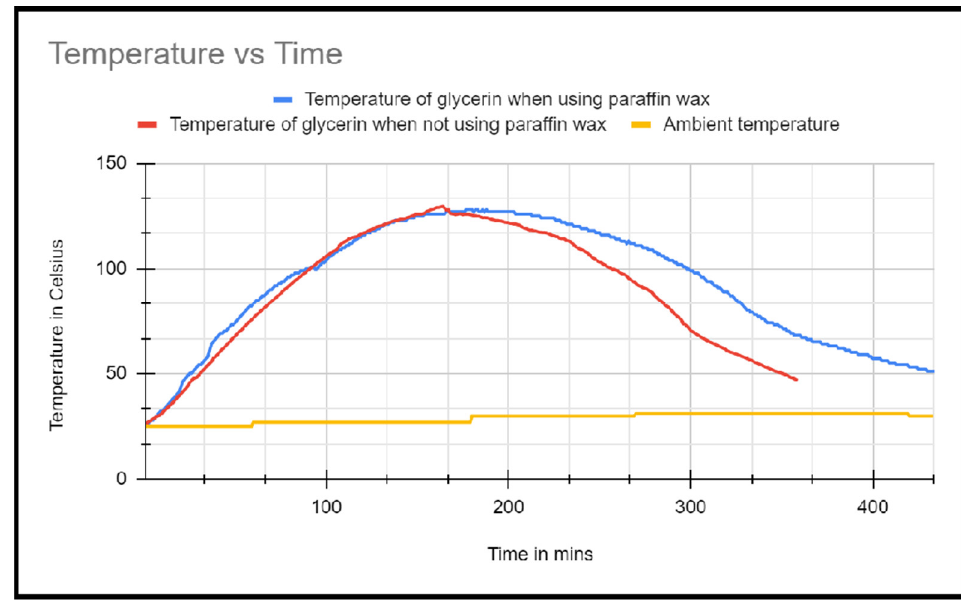
Figure 15. Time vs. temperature plot of glycerin when using paraffin wax and not using paraffin wax.